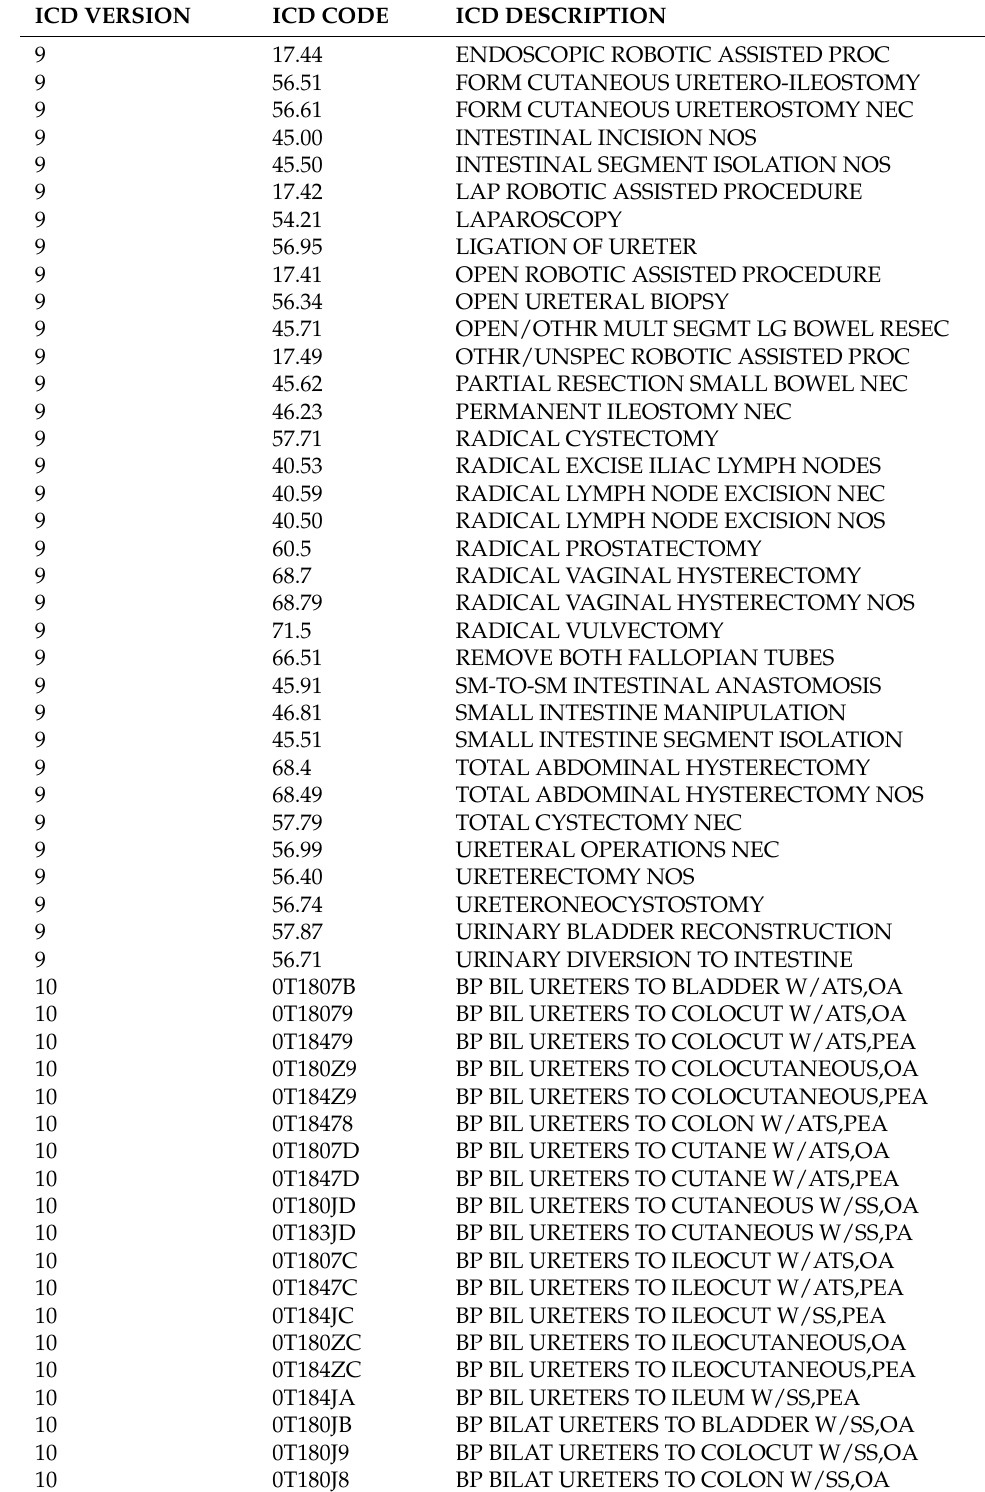
Table A2. International Classification of Diseases, 9th and 10th (ICD-9 and ICD-10) for proce- dure